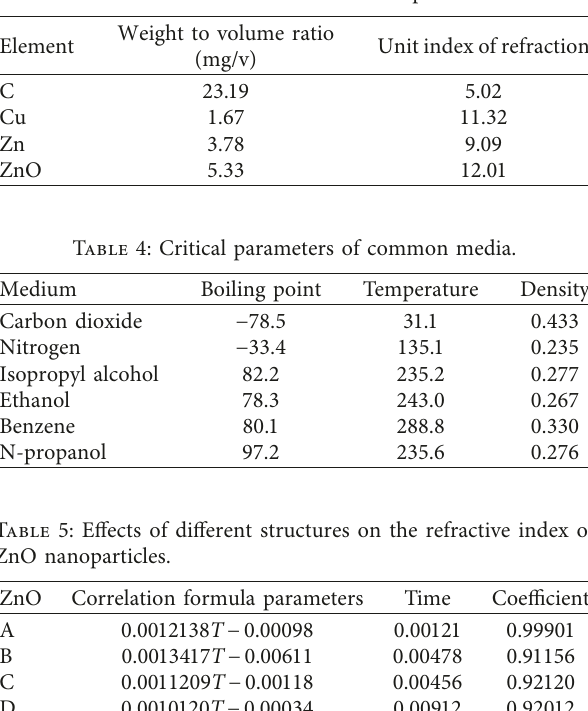
Table 2: Test results of different particle elements. Table 3: Unit refractive index of different particle elements.